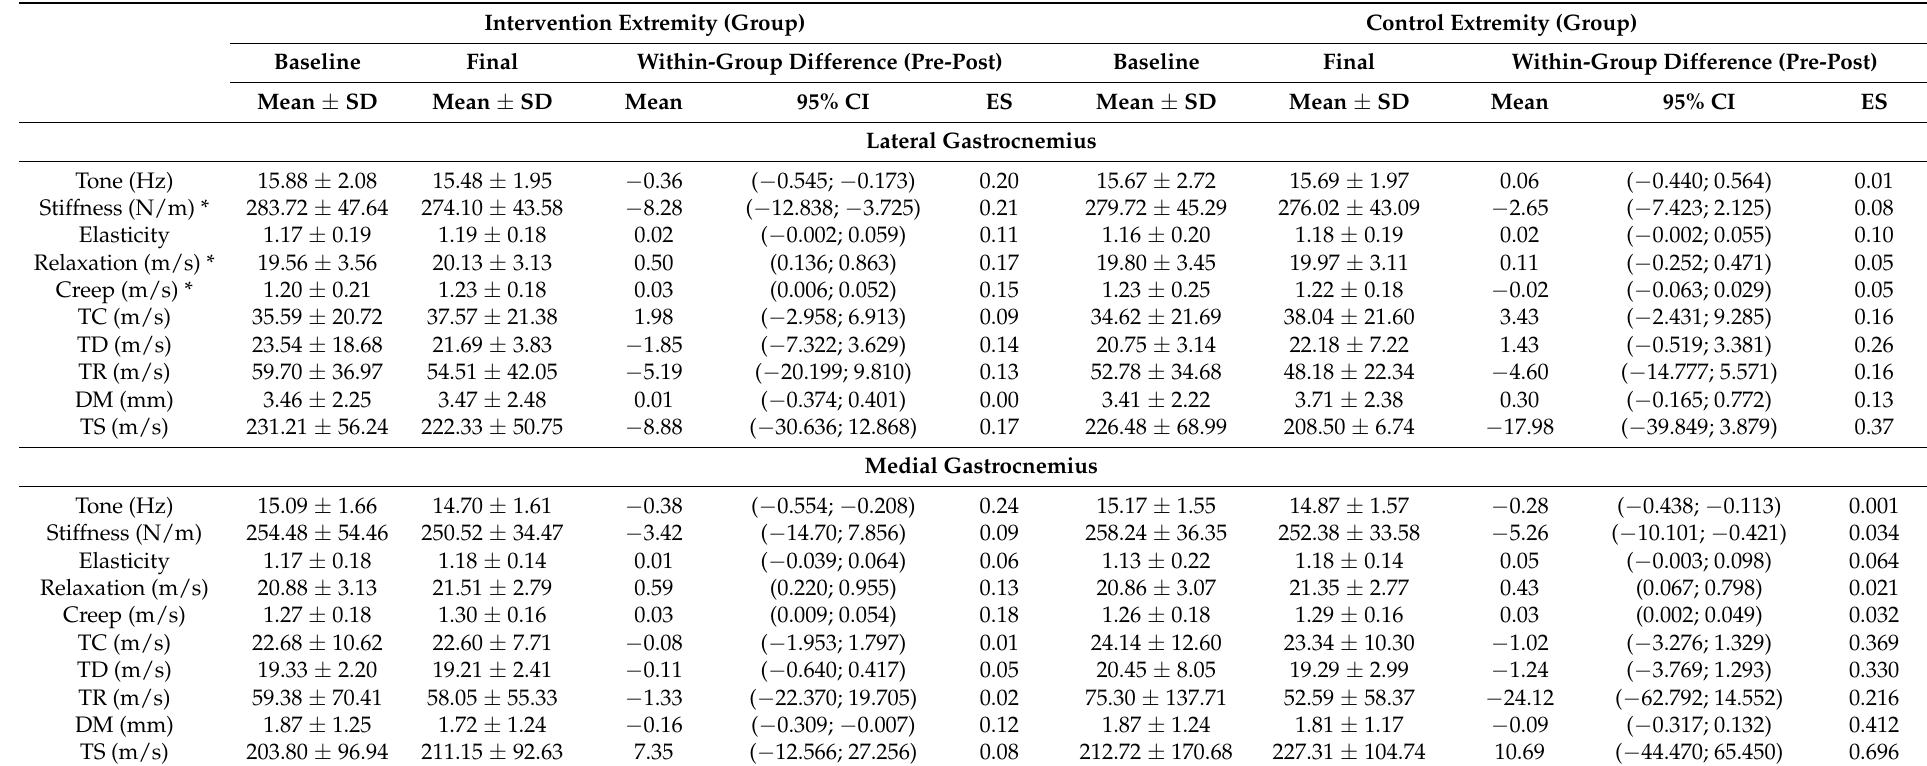
Table 1. Mean changes in neuromuscular function, according to myotonometry and